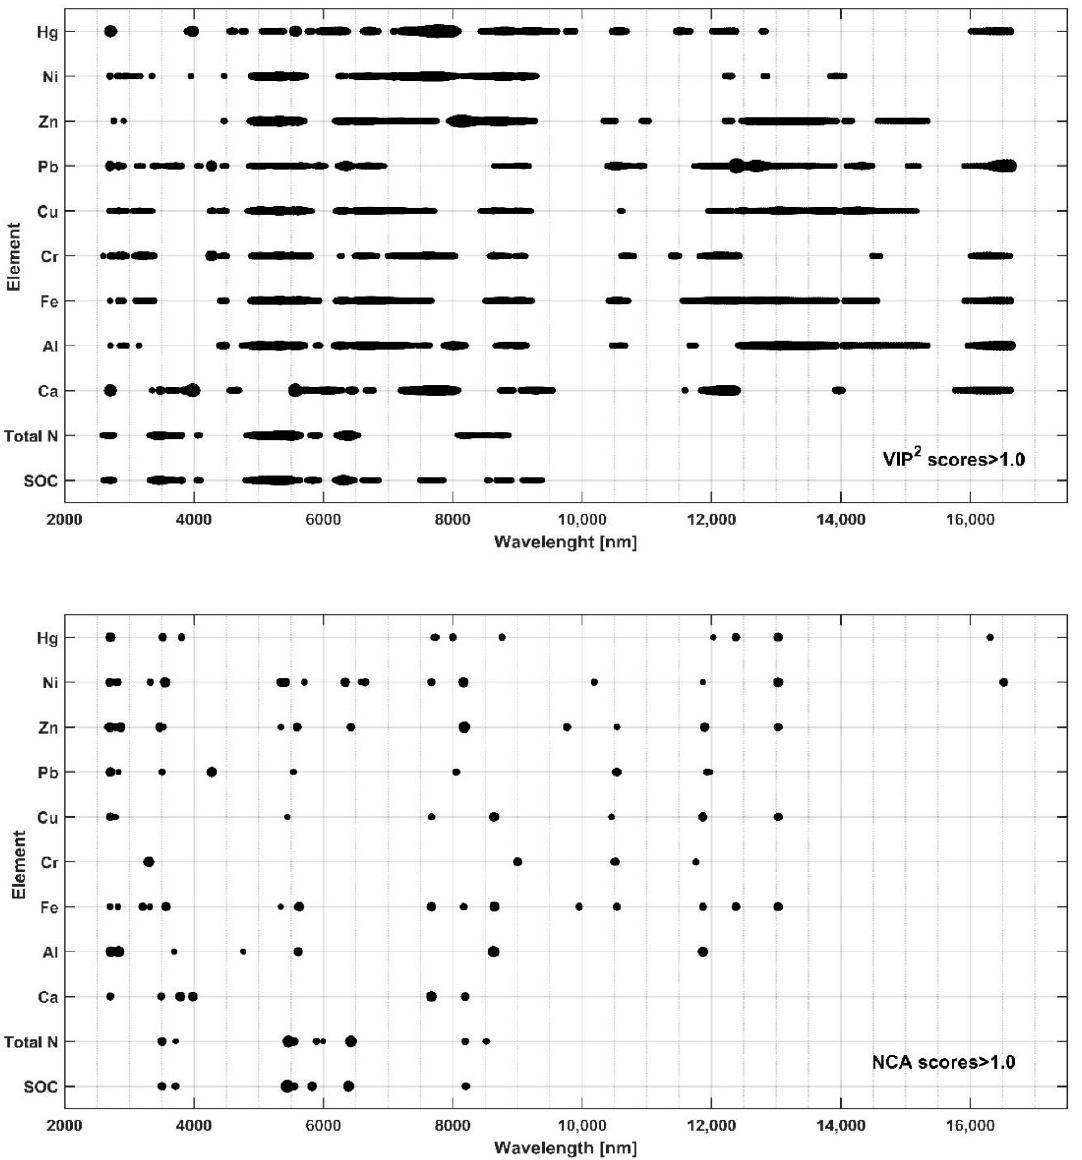
Figure 8. Distribution diagrams of squares of VIP scores and NCA scores for selected soil properties. The diagrams include index values exceeding 1.0. The diameters of points are proportional to the squares of VIP scores and NCA scores.